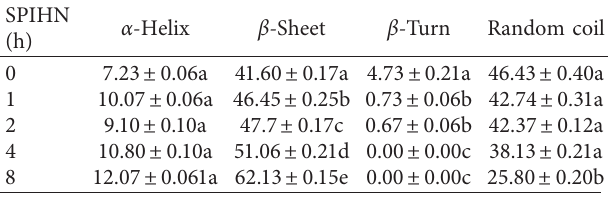
Different letters in the same column indicate significant differences ( p < 0 .